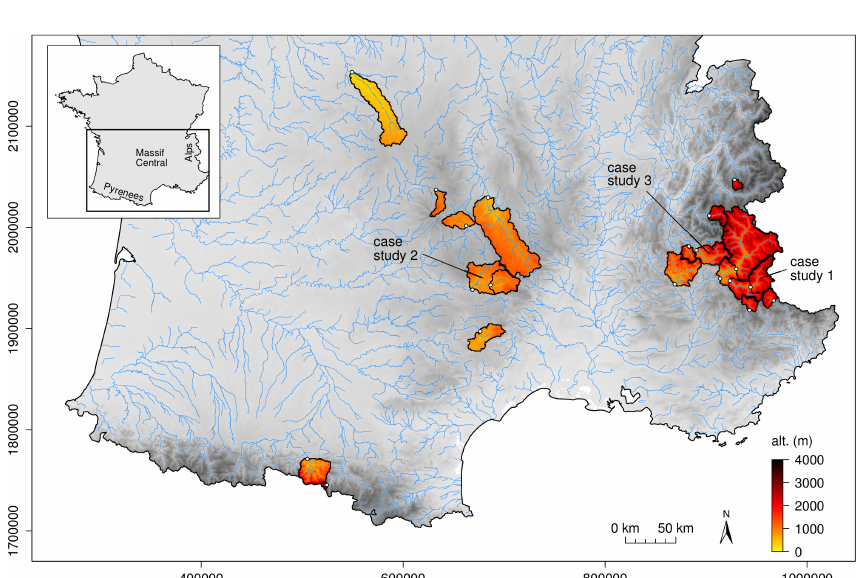
Fig. 1. Locations of the 20 catchments used in this